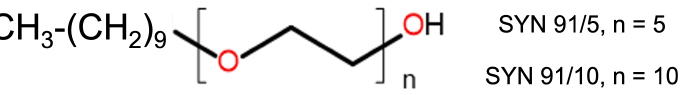
Figure 2. Chemical structure of the